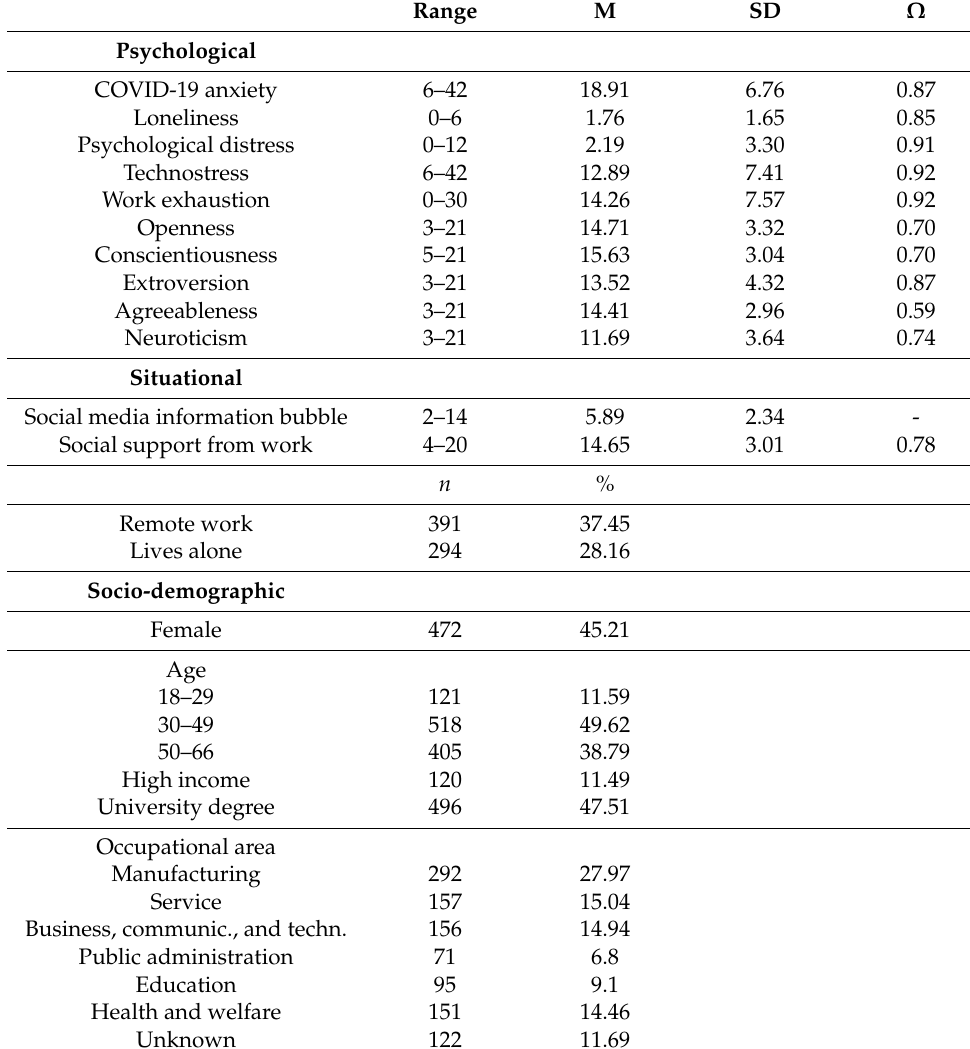
Table 1. Descriptive statistics of study